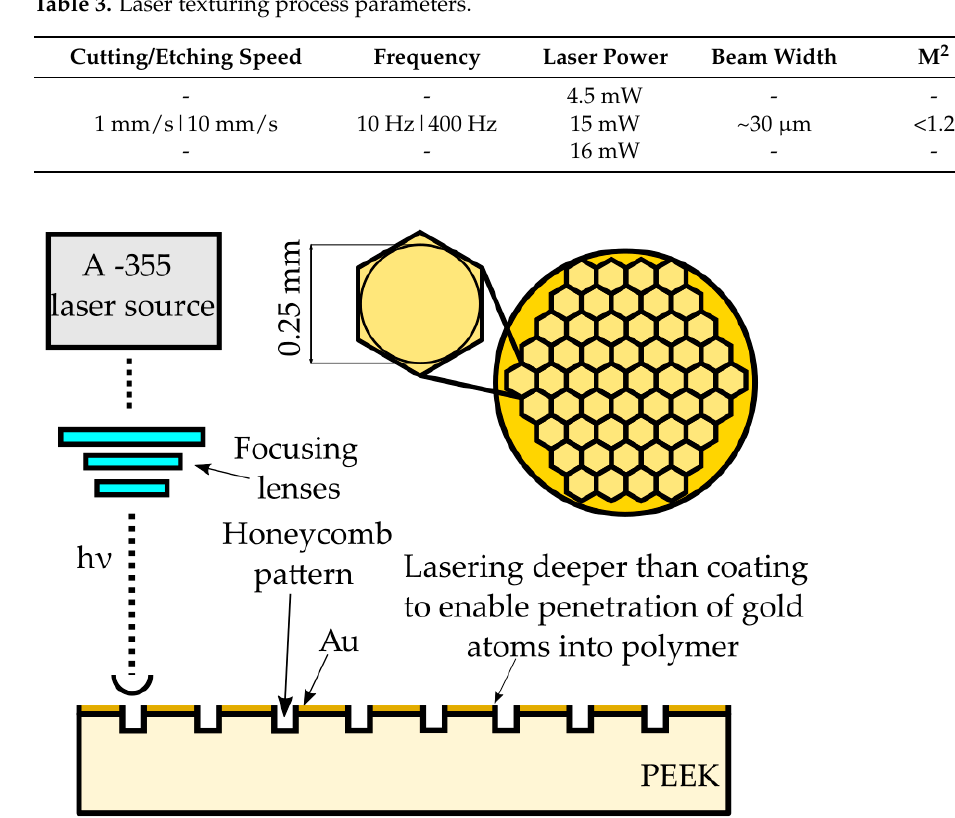
Figure 2. Laser micromachining scheme. PEEK: polyether ether ketone.